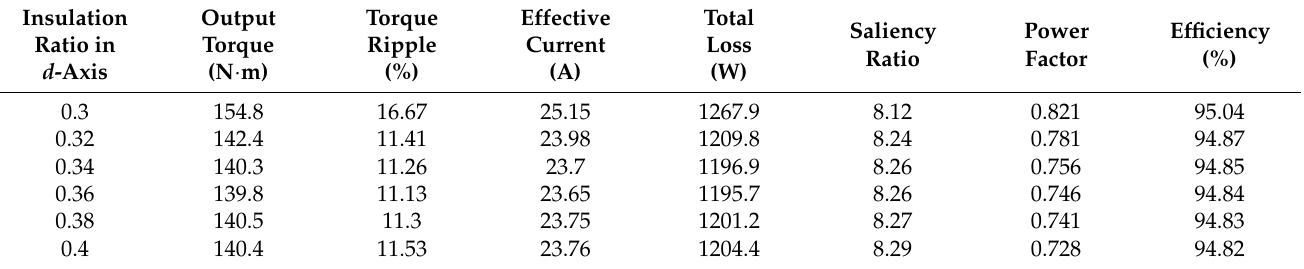
Table 6. Analyzes on d -axis insulation ratio.